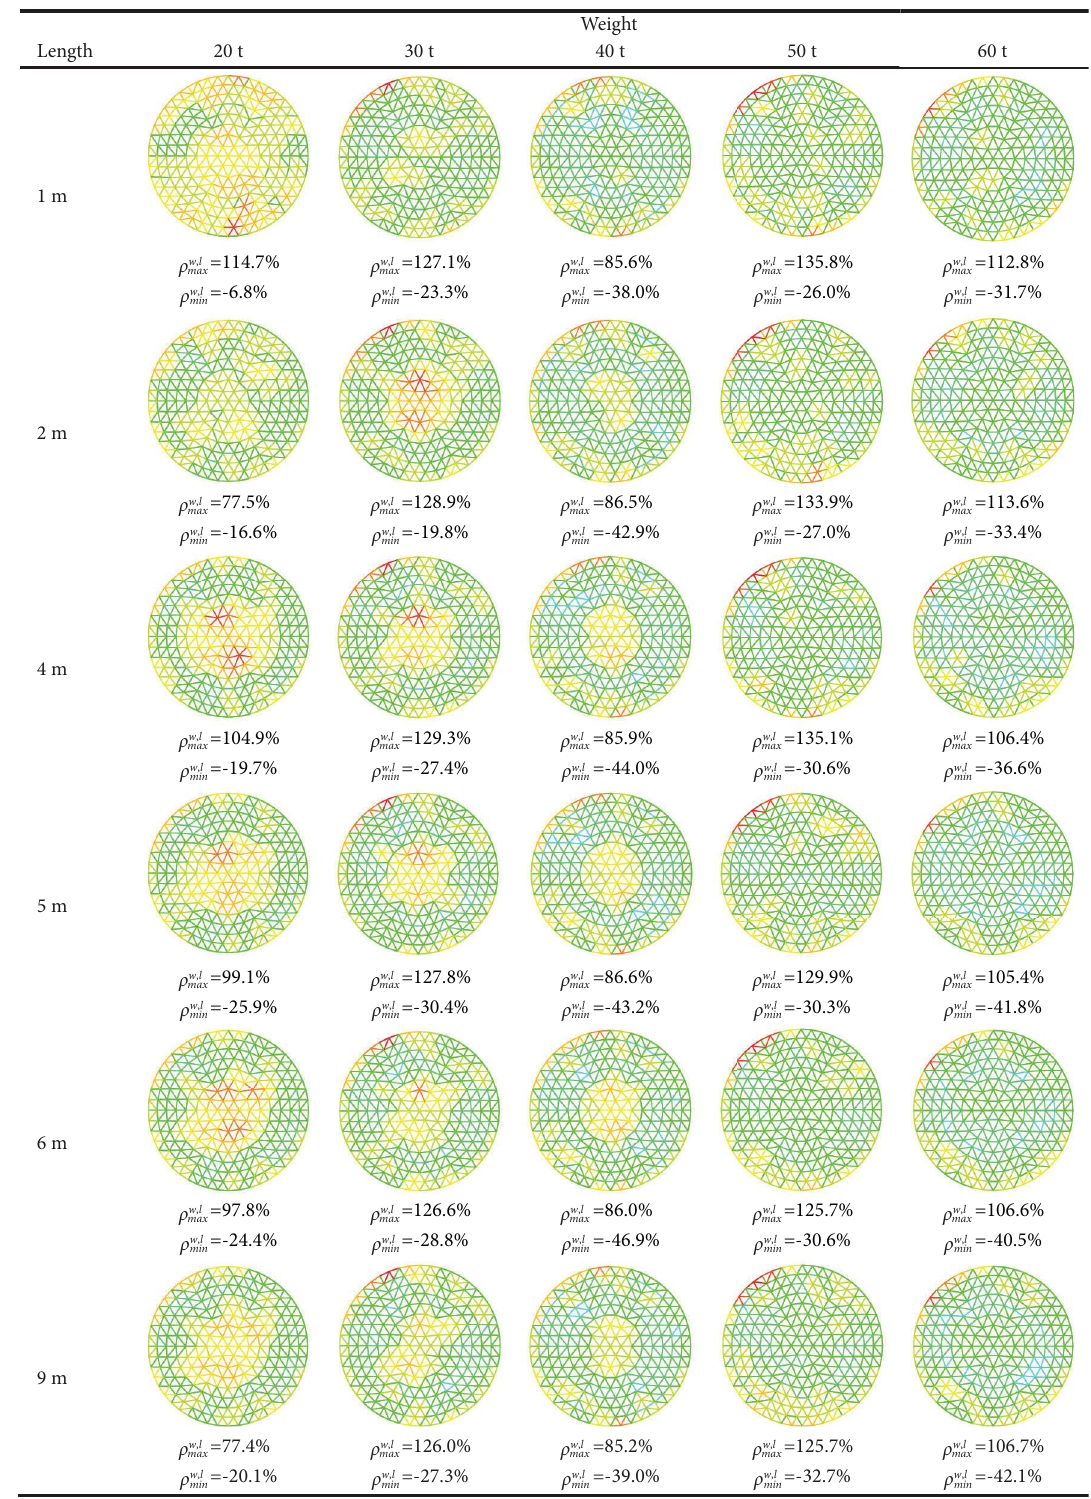
w,l , and ρ w,l values in the y i, max ρ min max